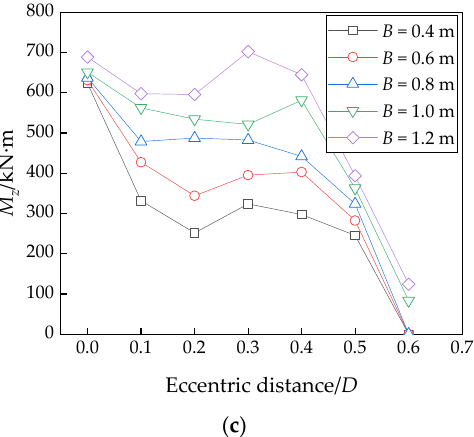
Figure 19. Effect of the eccentric distance e on the moments: ( a ) M x ; ( b ) M y and ( c ) M z .